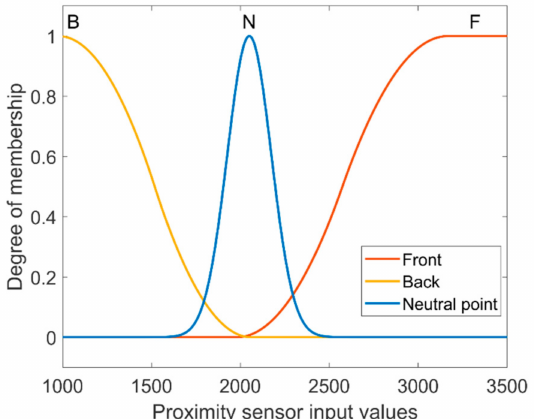
Figure 12. Defuzzification stage for the back and forward